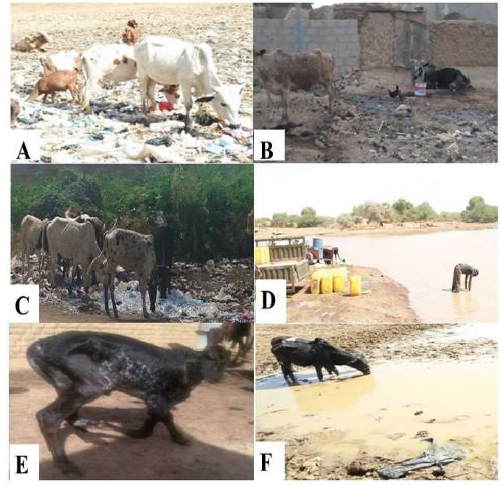
Figure 4. Exposure of Animals to the Human Excreta ( A , B ), Plastic Waste ( C ), Taking Water by the Mining in Activities ( D ), Newborn deformities ( E ) and Drinking in Mare ( F ).